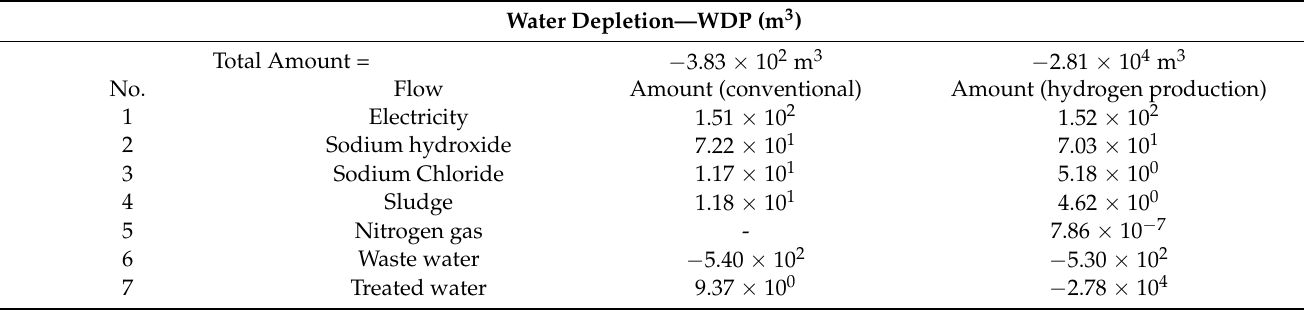
Table 10. Details of water depletion impact.